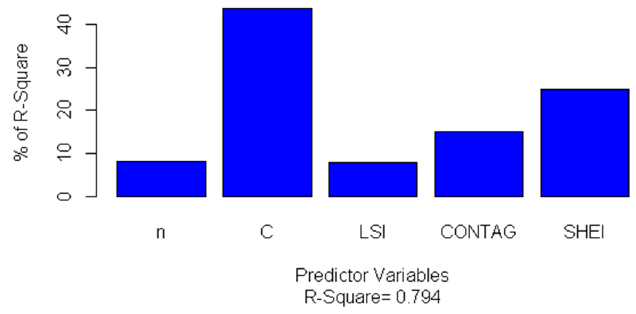
Figure 10. Relative importance of the predictor variables used in this study.